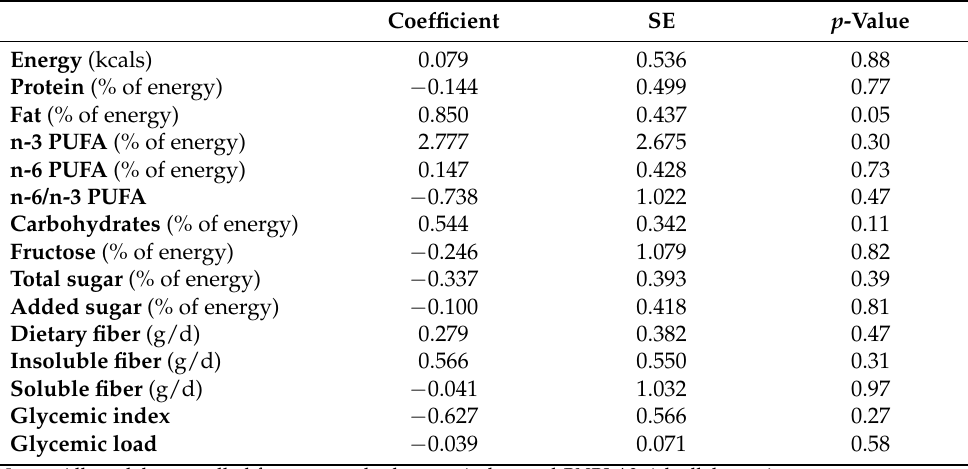
Table A1. Beta coefficients for the associations of dietary variables of interest with liver steatosis from separate multivariable linear regression models (Sensitivity Analyses).